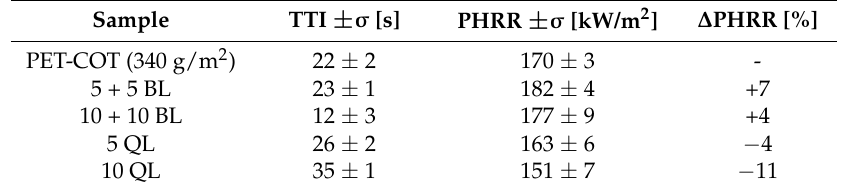
Table 17. Combustion data of untreated and LbL-treated PET-COT by cone calorimetry (35 kW/m 2 ) [31]. Sample